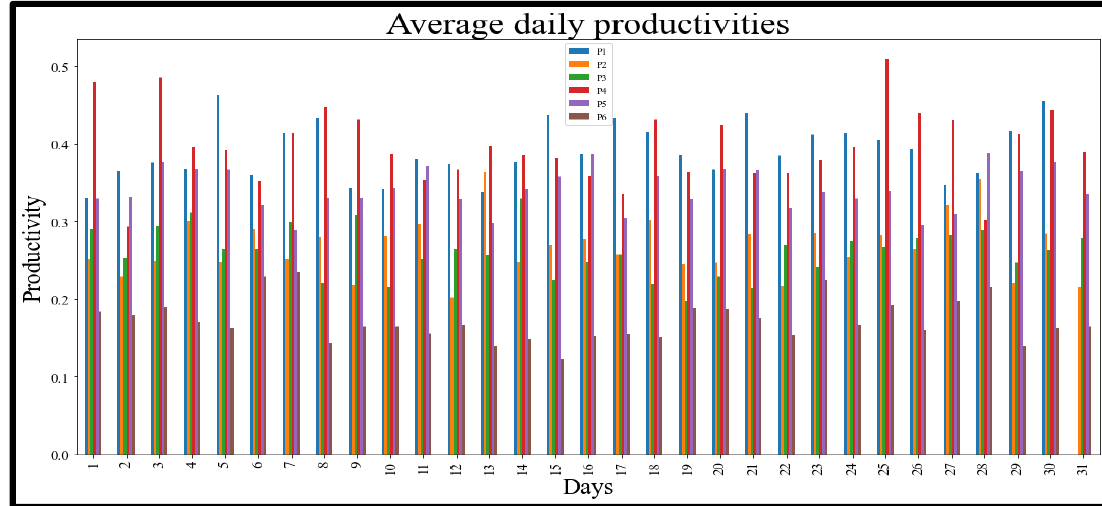
Figure 20. Daily Productivities. Figure 20. Daily